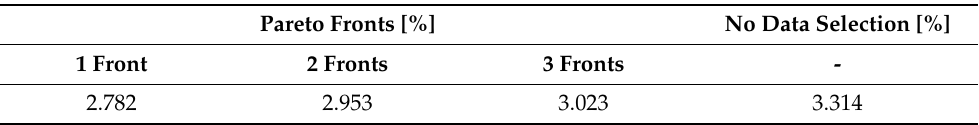
Table 14. MAPE values for Pareto fronts and ‘no data selection’ models for the benchmark simplified 2015 verification case.